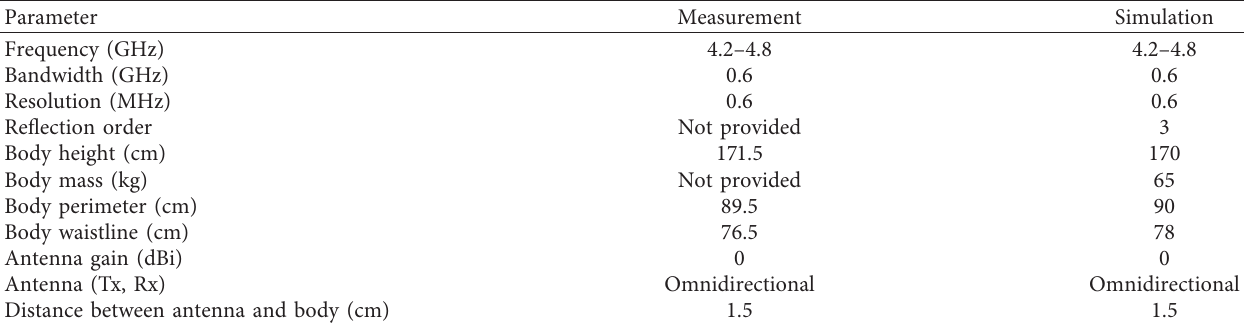
Figure 12: Positions of the Tx and Rx. (a) Measurement position B [25]. (b) Simulation with human body model 2 in Table 11. Table 12: The parameters of experiment around the